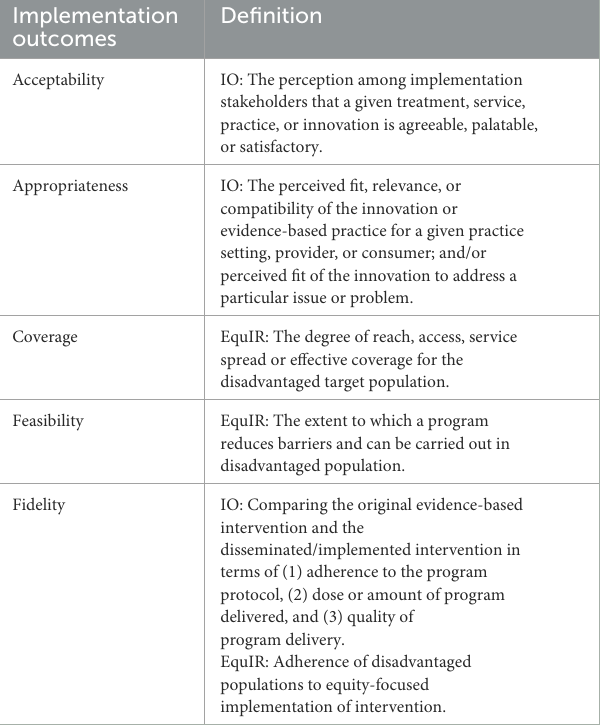
TABLE 2 Implementation outcomes [IO; (36)] and EquIR (35) frameworks for thematic analysis of qualitative components. Implementation